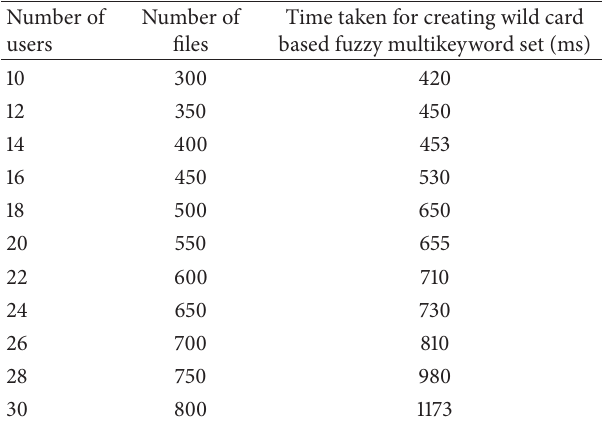
Table1:Analysisoftimetakenforcreatingthewildcardbasedfuzzy multikeyword